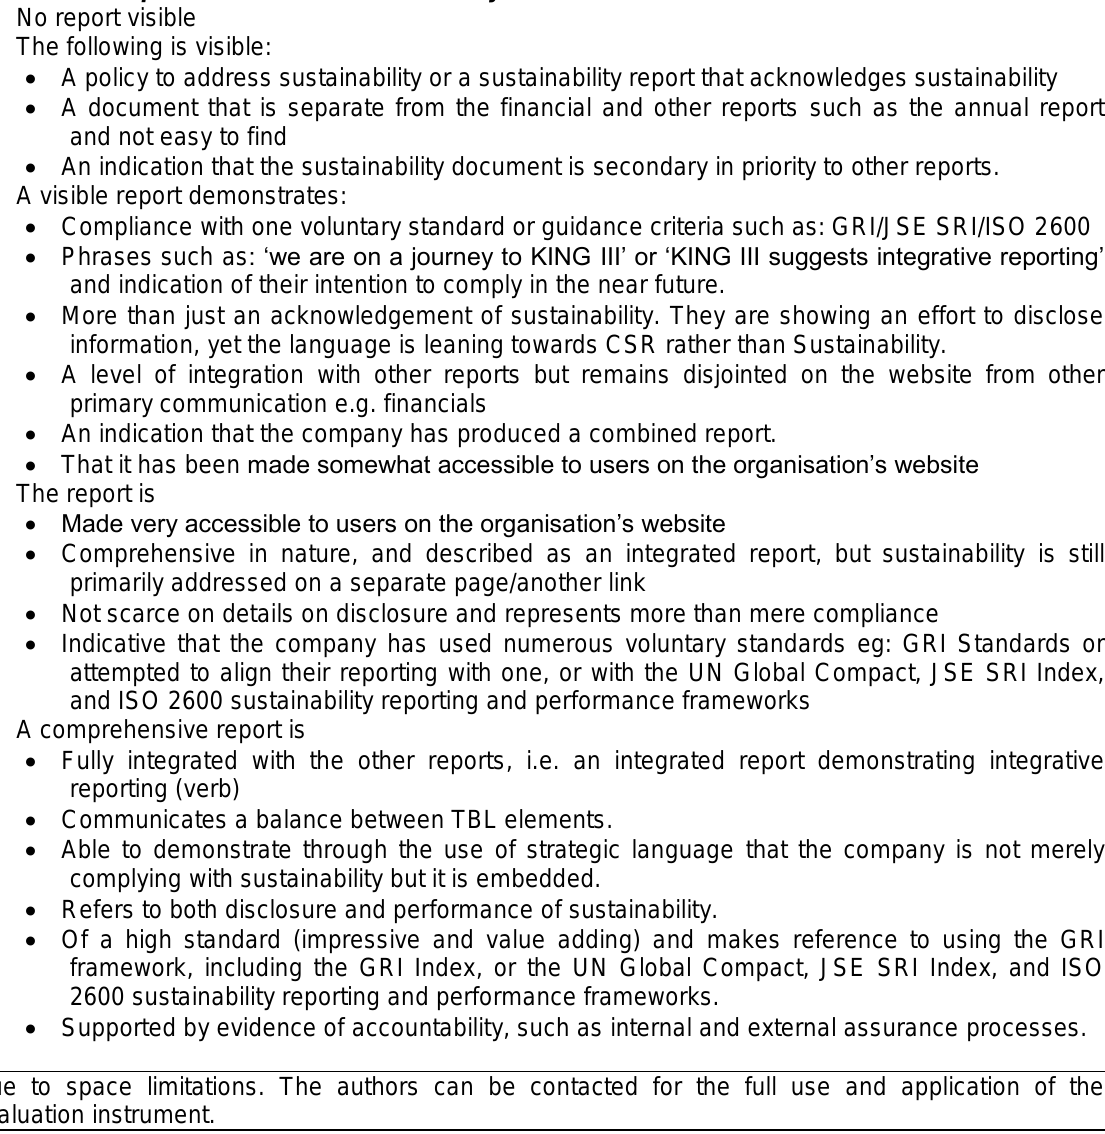
Phrases such as : ‘we are on a journey to KING III’ or ‘KING III suggests integrative reporting’ and indication of their intention to comply in the near